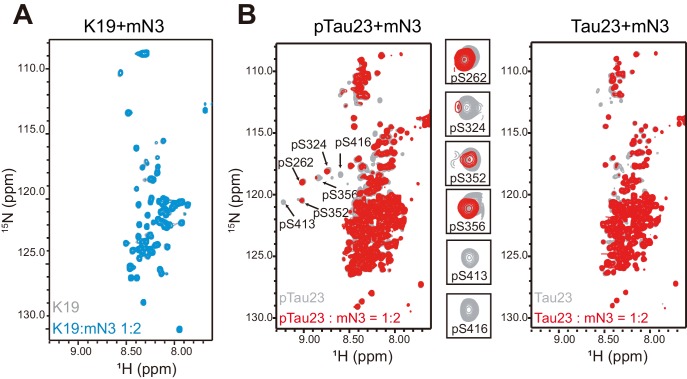
NMR titration of NMNAT to Tau.(A) Overlay of 2D 1H-15N HSQC spectra of K19 alone (100 μM, gray) and K19 titrated by mN3 (blue; molar ratio 1:2). (B) Overlay of 2D 1H-15N HSQC spectra of pTau23 (left)/Tau23(right) alone (100 μM, gray) and that titrated by mN3 (red; molar ratio 1:2). pSer residues are enlarged.